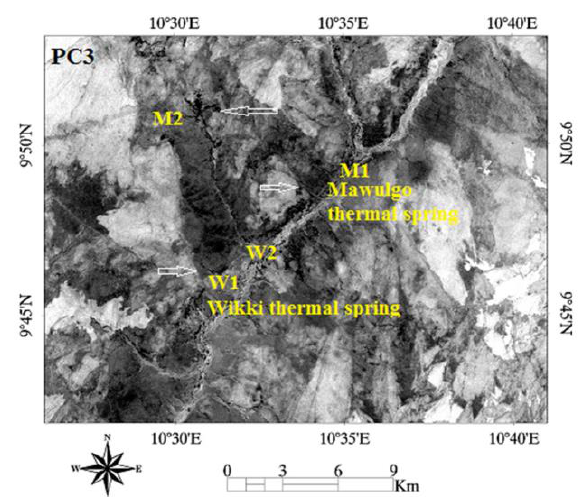
Figure 2. PC3 showing dark pixels as possible alteration zones due to hydroxyl-bearing minerals.